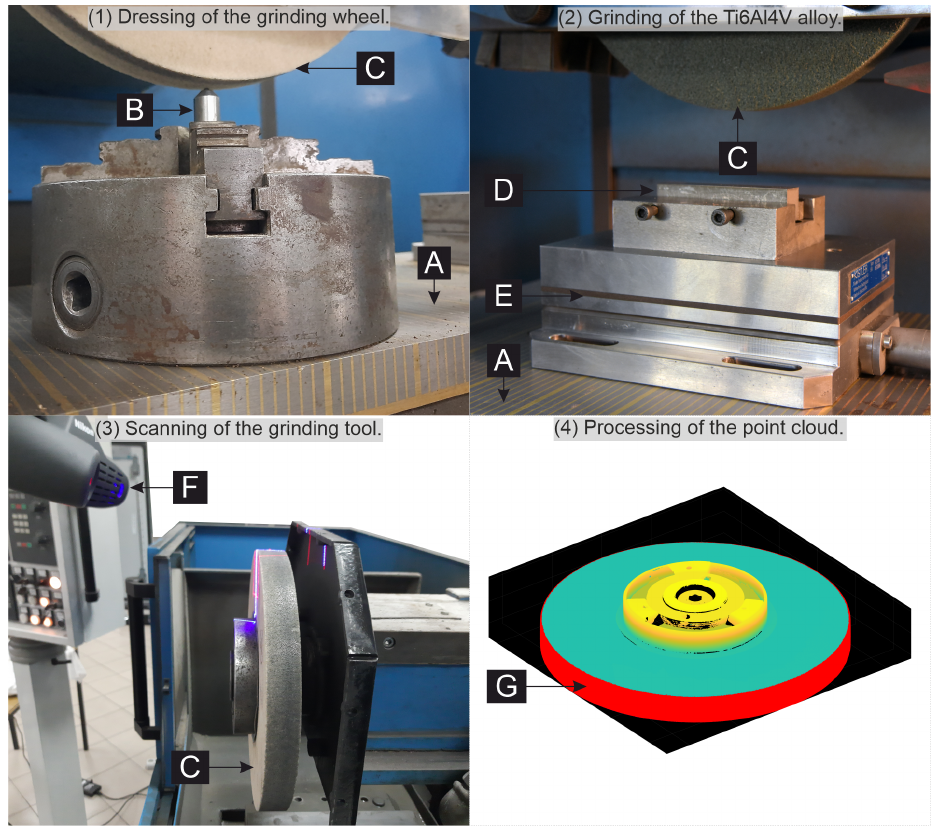
Figure 5. Methodology of the experimental research; A —magnetic table, B —single grain dresser, C —grinding wheel, D —workpiece, E —sample holder, F —scanning head, G —scanned point